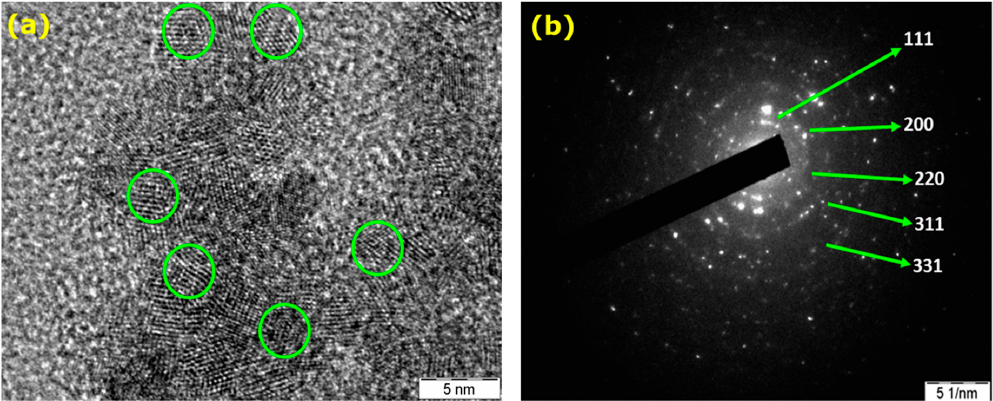
Figure 1. X-ray di ff raction pattern of as-prepared AgNPs. Figure 1. X-ray diffraction pattern of as-prepared AgNPs.